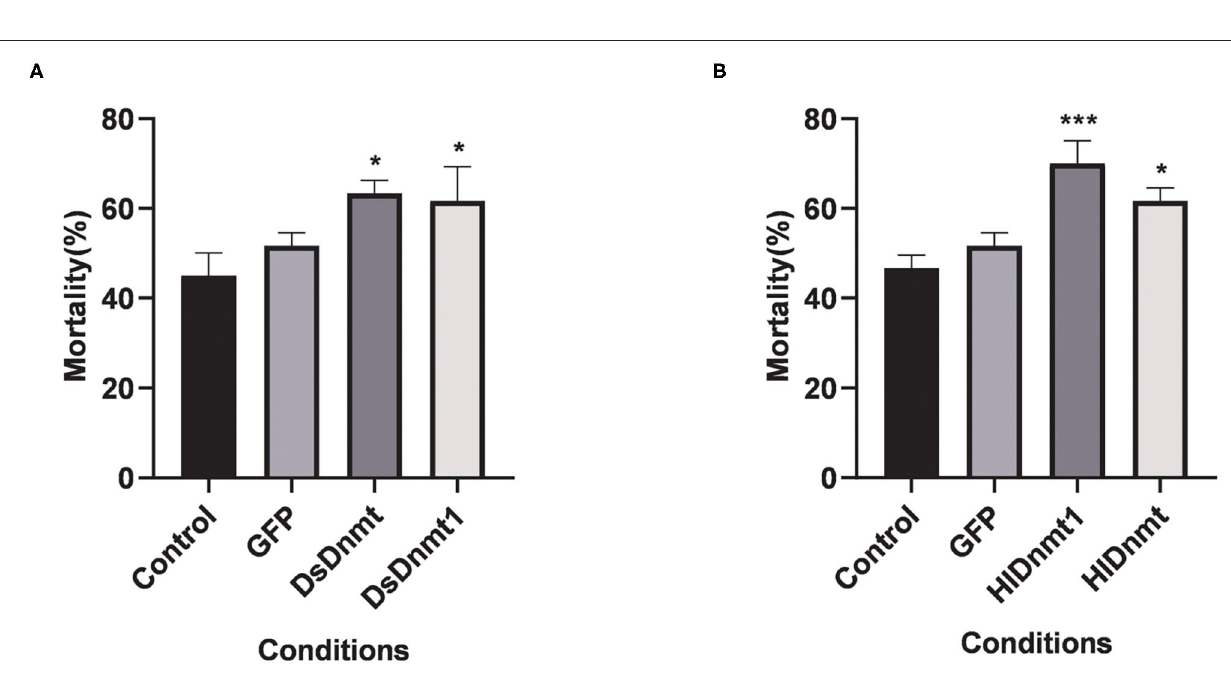
FIGURE 6 | The effects on the cold tolerance of ticks after the knockdown of Dnmts . (A) The mortality rate of D. silvarum after cold treatment post DsDnmt and DsDnmt1 knockdown. The mortality rate increased significantly in the ticks with Dnmts’ knockdown in relation to the controls. (B) The mortality rate of H. longicornis after cold treatment post HlDnmt1 and HlDnmt knockdown H. longicornis . The mortality rate increased significantly in the ticks with Dnmts’ knockdown in relation to the controls. The results are expressed as the means ( n = 3) ± SEM. The asterisks above bars indicate significant difference based on one-way ANOVA followed by Turkey’s test, * P < 0.05, *** P <